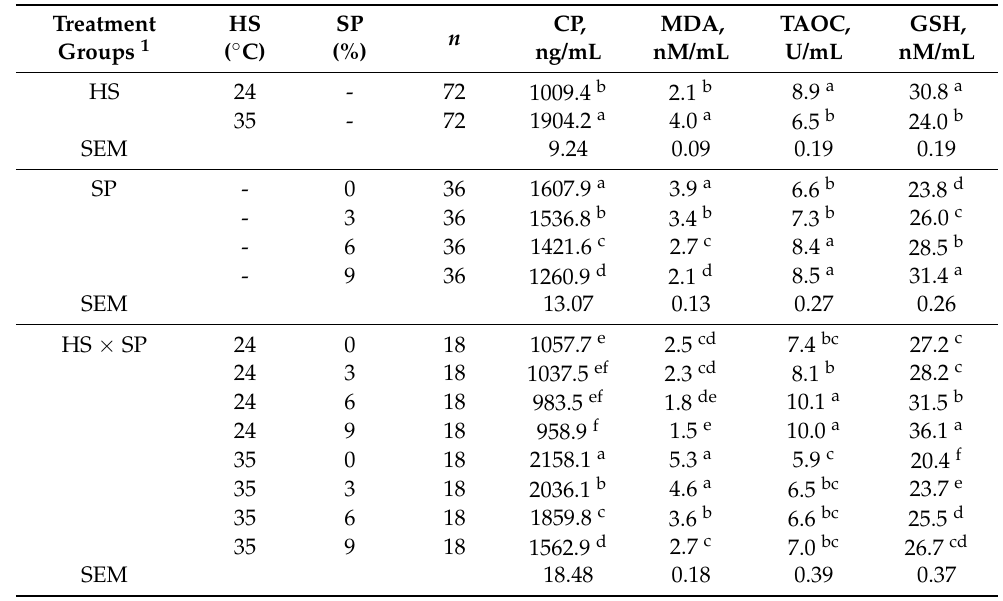
Table 4. Effect of dietary Spirulina platensisis (SP) supplementation on the redox status of laying hens exposed to cyclic heat stress